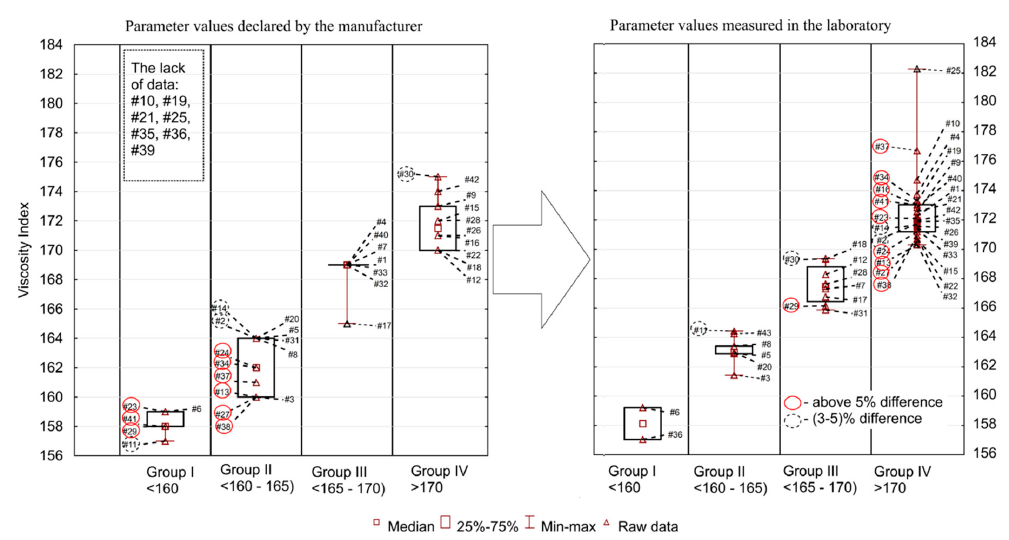
Figure 3. The viscosity index of the engine oil samples tested.